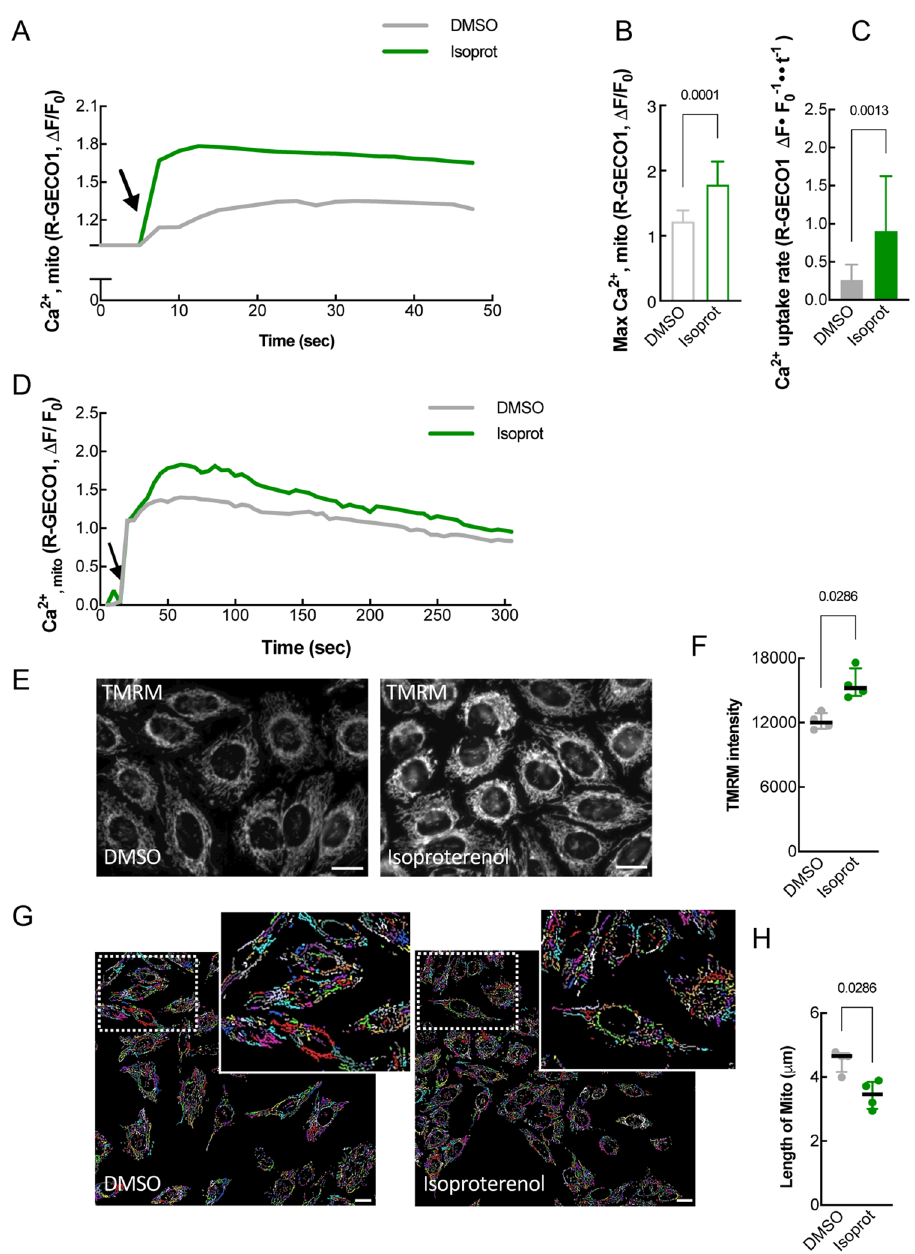
Figure 3. β2-AR agonists enhance functional coupling between ER and Mito. ( A ) Mito Ca 2+ uptake in response to histamine (100 μM). Mito-R-GECO1 fluorescent intensity change averaged over multiple cells (HeLa) is plotted every 2.5 s in DMSO- or isoproterenol- treated cells. Arrow: histamine addition. ( B ) Maximum peak of Mito Ca 2+ uptake (as in A ). Unpaired two-tailed t-test ( n = 10, DMOS; 14, Isoprot). ( C ) Mito Ca 2+ uptake rate (as in A; 7.5 to 12.5 s). Mann–Whitney test ( n = 12, DMSO; 11, Isoprot). ( D ) Mito Ca 2+ uptake (HeLa cells) in response to ionomycin (3 μM). Mito-R-GECO1 fluorescent intensity change is plotted every 5 s. ( E ) Representative images of TMRM signal (for Mito membrane potential) (HeLa cells). ( F ) Quantification of TMRM intensity as in E. Unpaired two-tailed t -test with Welch’s correction ( n = 4 with 52 cells each). ( G ) Representative images of Mito (converted in Image Analyst MKII software) used for length comparison (HeLa cells, 1 μM drug). ( H ) Quantification of Mito length as in ( G ). Mann Whitney test ( n = 4 with 616 (DMSO) or 948 (Isoprot) mitochondria for each experiment). Each drug: used at 1 μM final conc. Data in ( B , C ): mean ± SD; data in ( F , H ): median with interquartile range. Scale bars: 10